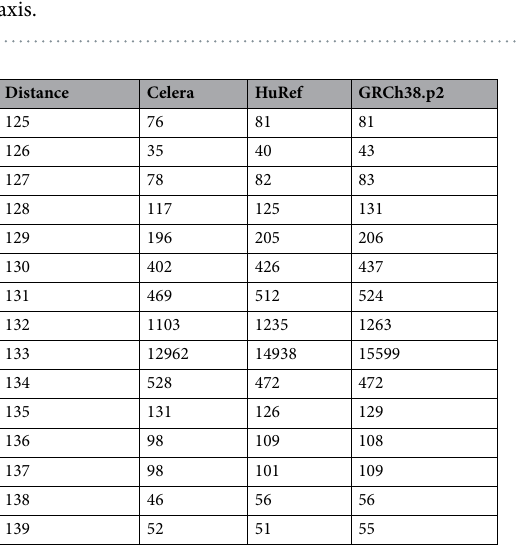
Table 3. DNRC partial distribution of CCACAAT , around distance 133, for three distinct human genome assemblies (Celera, HuRef,